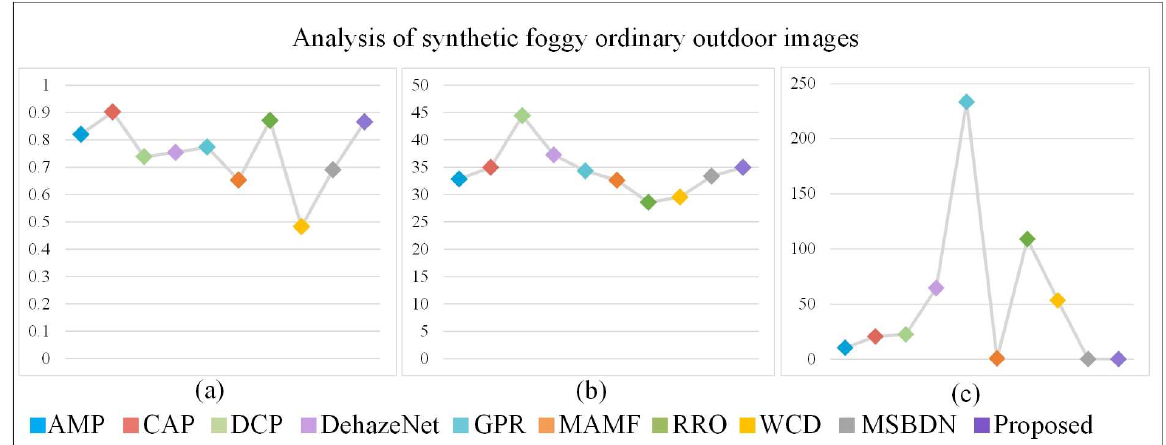
Figure 13. Analysis of ten image defogging methods in synthetic foggy ordinary outdoor scenes, ( a ) SSIM, ( b ) PSNR, ( c ) processing